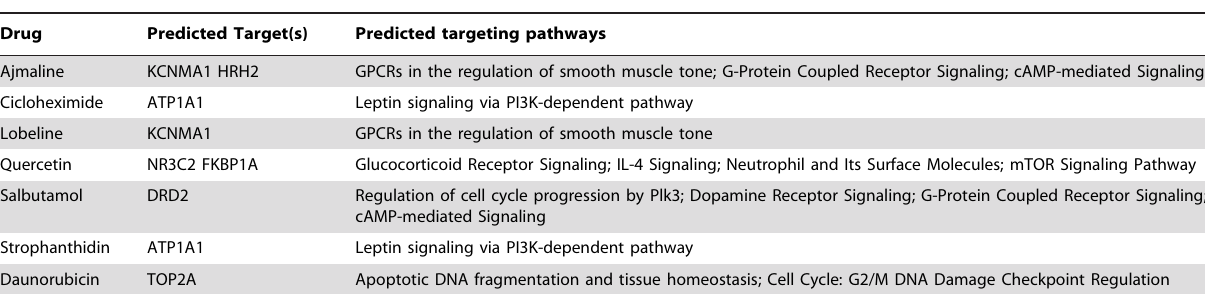
Table 3. A manual selection of compounds with predicted drug target(s) based on similarity in expression profiles to another drug with known